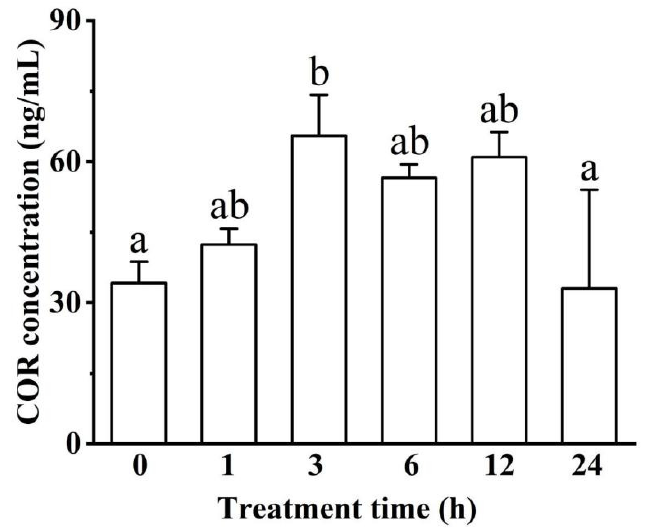
Figure 4. Effect of acute hypoxia on cortisol (COR) concentration in blood serum. Different letters indicate significant differences ( p < 0.05).